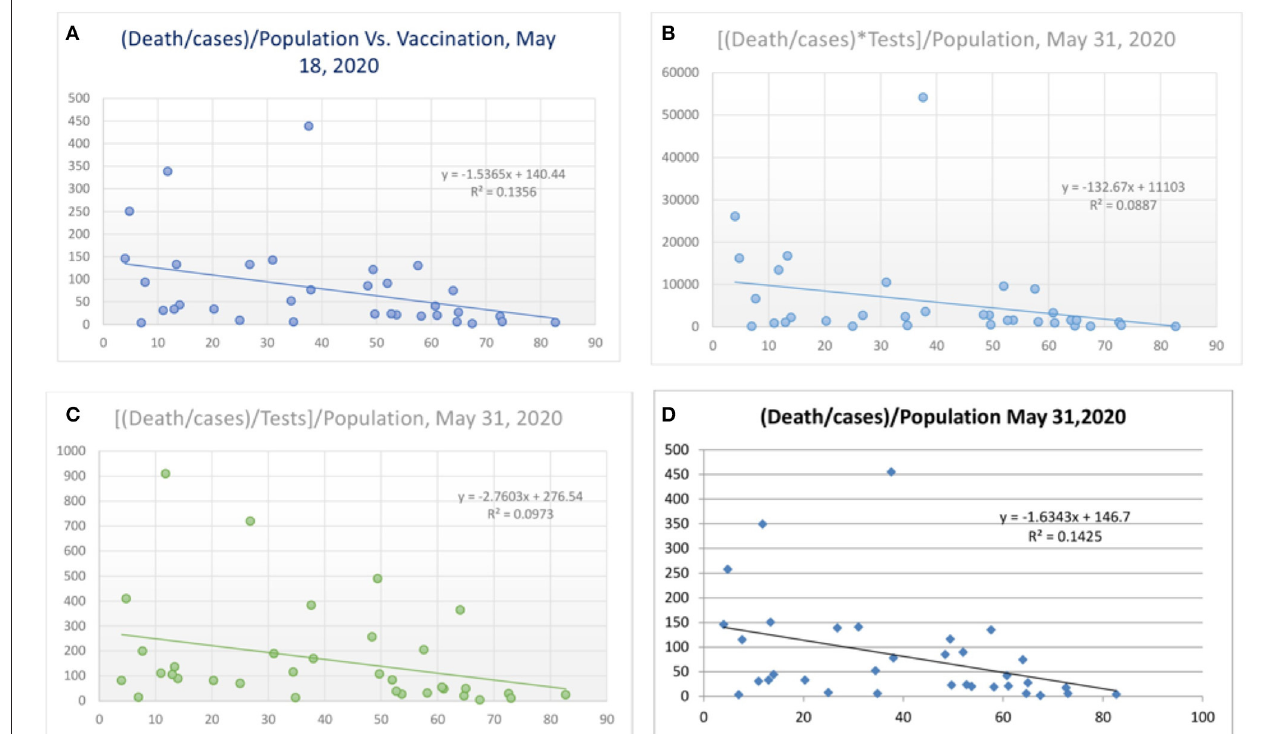
FIGURE 4 | Correlation between vaccination and death per million/cases per million adjusted to population [ (A) May 18, 2020 and (D) May 31, 2020] and tests performed [ (B) and (C) , May 31, 2020].